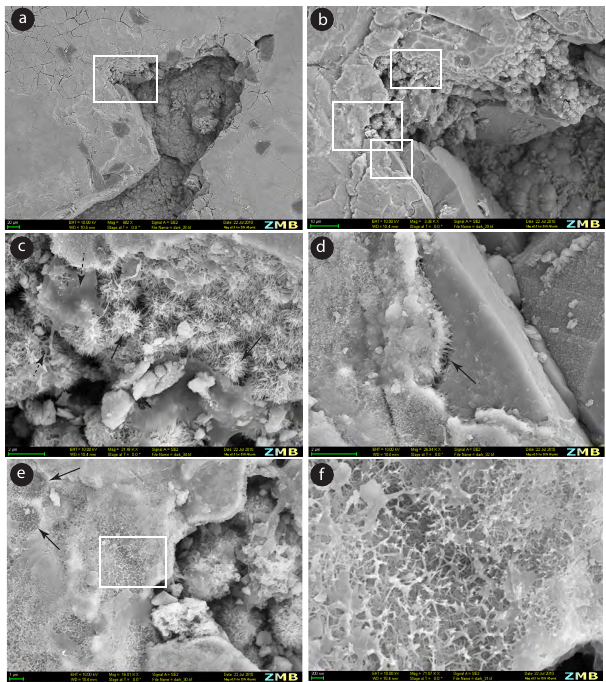
Fig. 12. Secondary electron images of the corrosion features: (a, b) calcite crystals corroded by iron oxides close to depressions, as shown by irregular outlines; (c) iron oxides characterized by fibrous radial structures (arrows), which are intermixed with EPS (dashed arrows); (d) the contact between calcite crystal and these crusts shows corrosion features (arrow); (e) where this cover is thin, mi- croborings are still visible (arrows); (f) iron oxides are composed of randomly arranged nanofilaments.